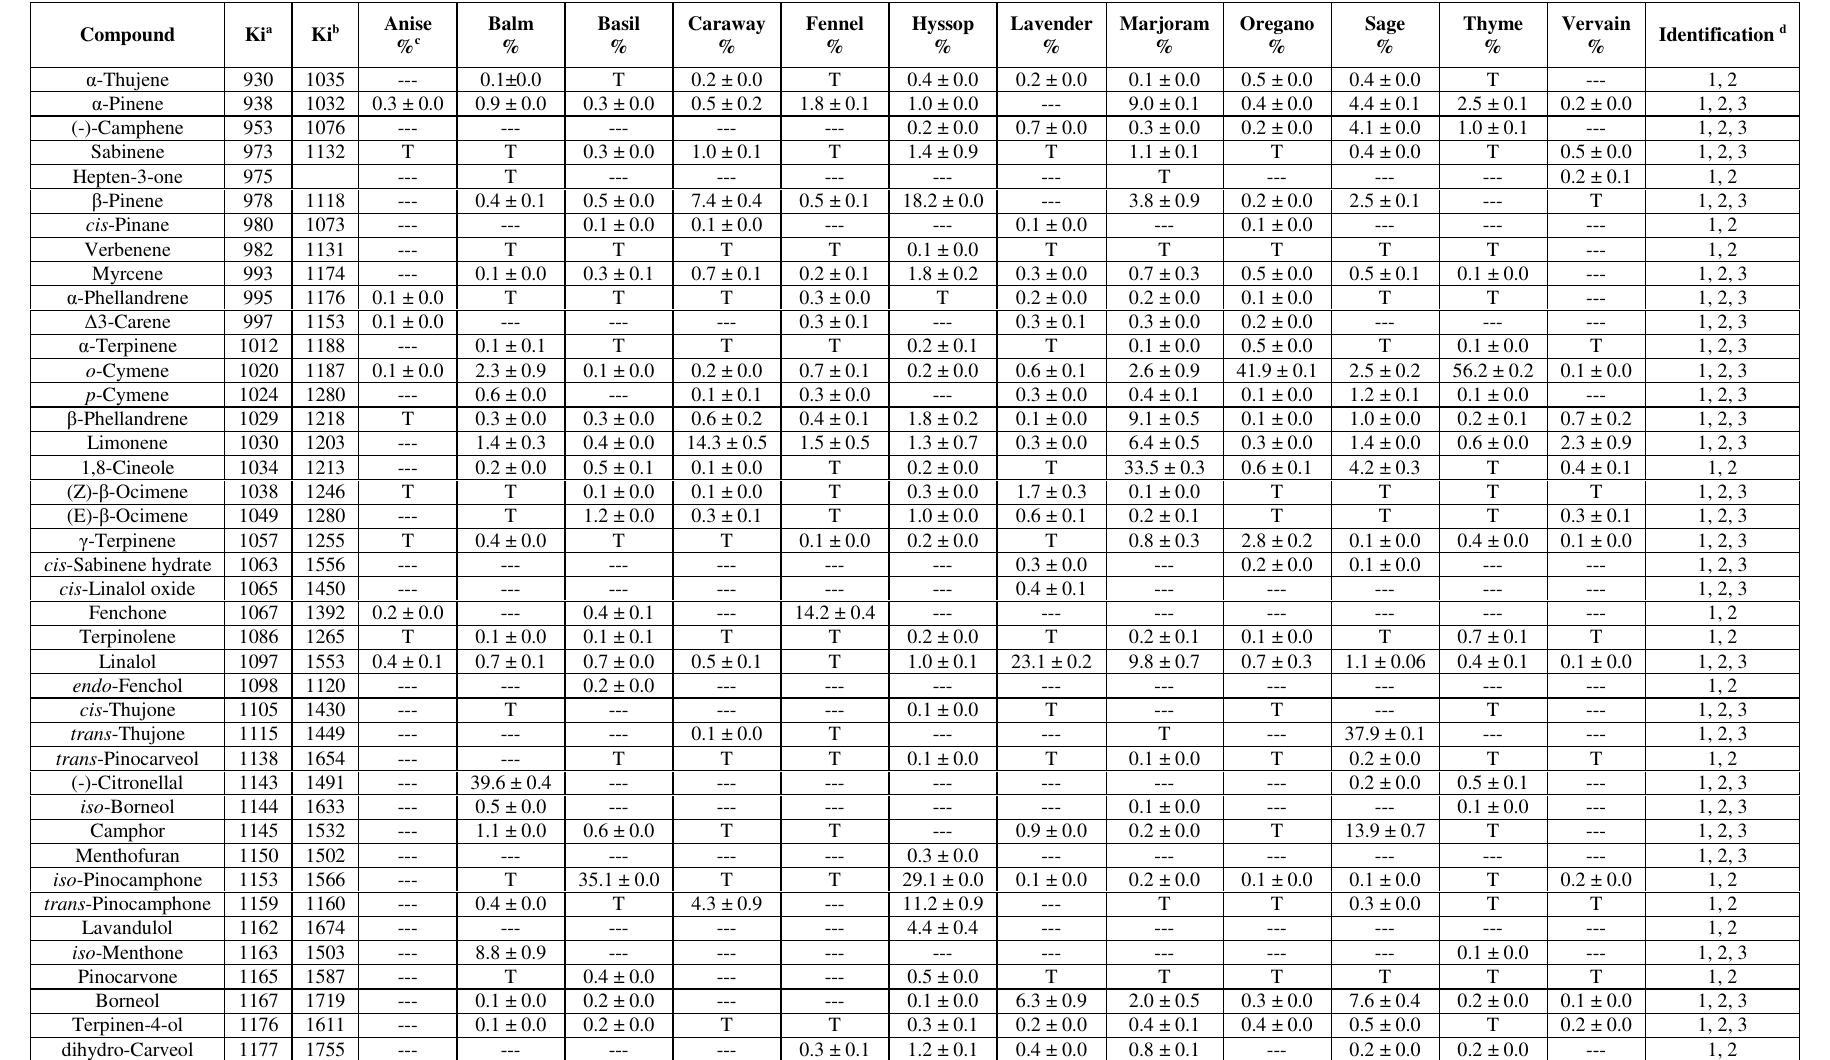
Table 1. Chemical composition of the studied essential